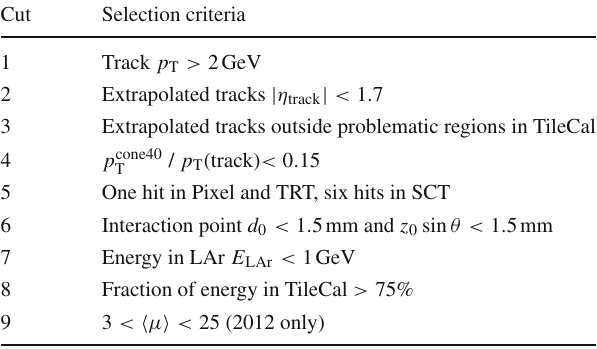
Table 9 The selection criteria used for the E / p analysis with single isolated